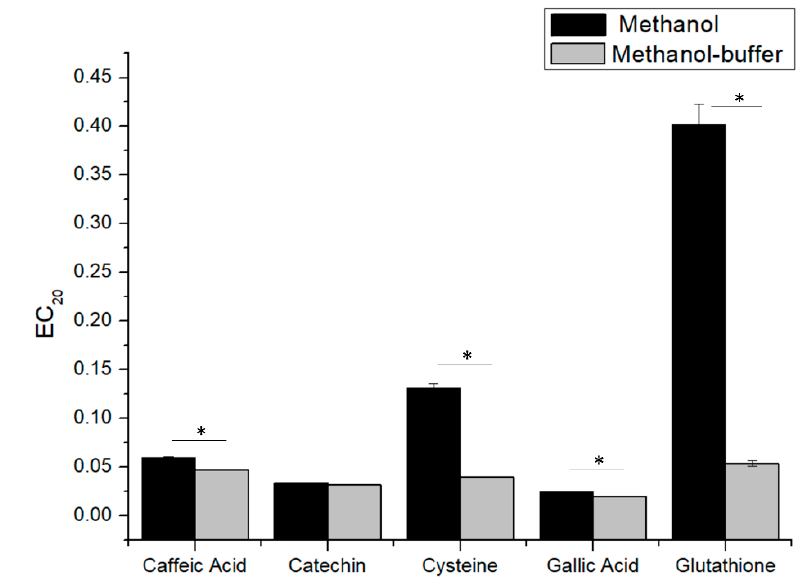
Figure 2. EC 20 values of gallic acid, catechin, caffeic acid, glutathione and cysteine measured in methanol ( (cid:4) ) and in methanol-buffer ( (cid:4) ). Student tests show comparison between methanol and methanol-buffer methods, “*” indicates significant differences ( p < 0.05).